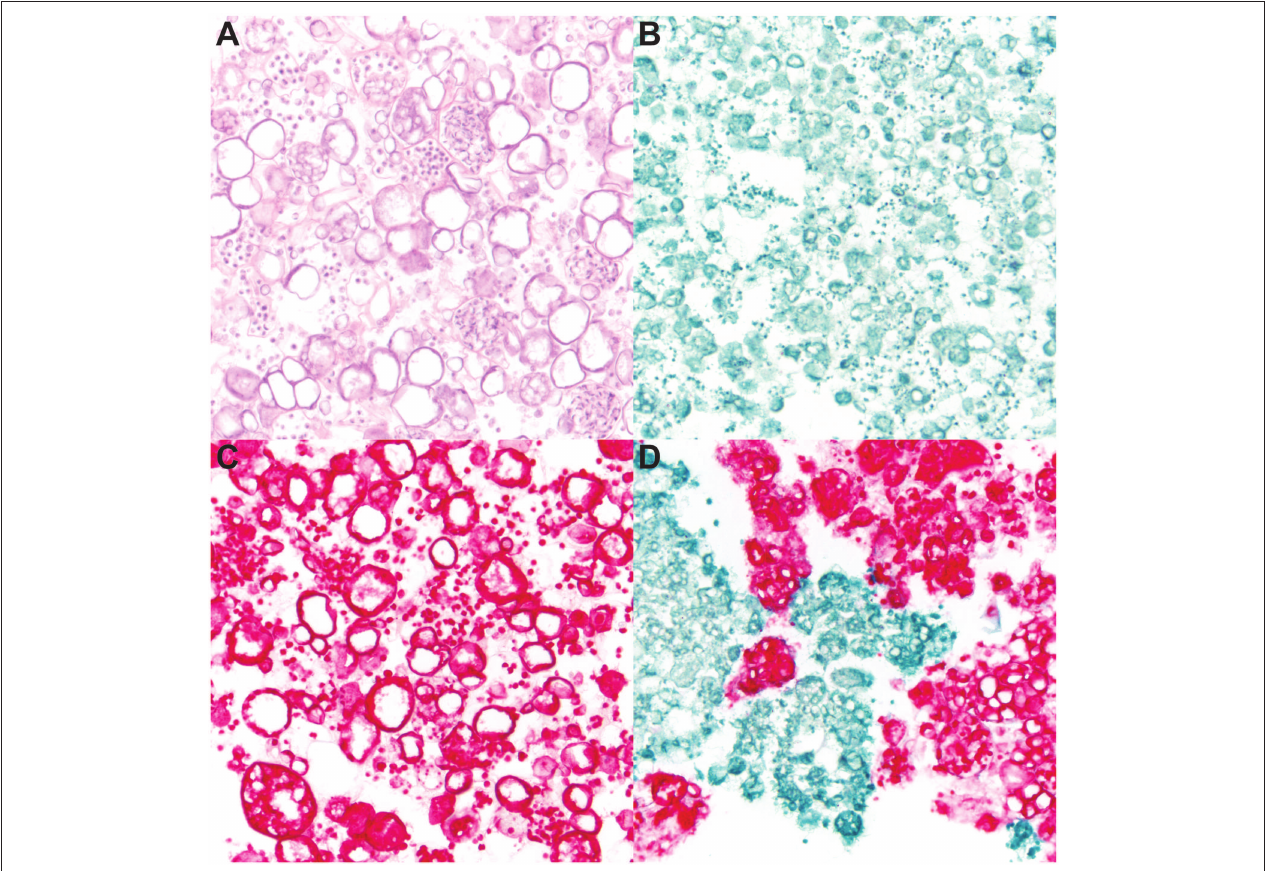
FIGURE 1 | RNAScope ® in situ hybridization (ISH) of cultured Batrachochytrium dendrobatidis ( Bd ) and B. salamandrivorans ( Bsal ). Ethanol fixed samples of mixed Bd / Bsal (A,D) , Bd alone (B) , or Bsal alone (C) were suspended in Histogel sample processing matrix and processed for histology. Samples were then stained with hematoxylin and eosin (A) and dual-plex chromogenic Bd/Bsal RNAScope ® ISH targeting the 28S rRNA gene. Bd probe binding is visualized by green staining (B,D) and Bsal probe binding is visualized by red staining (C,D) . Intact fungal sporangia containing zoospores, empty sporangia, and free zoospores are present in all samples. All images are at 600x